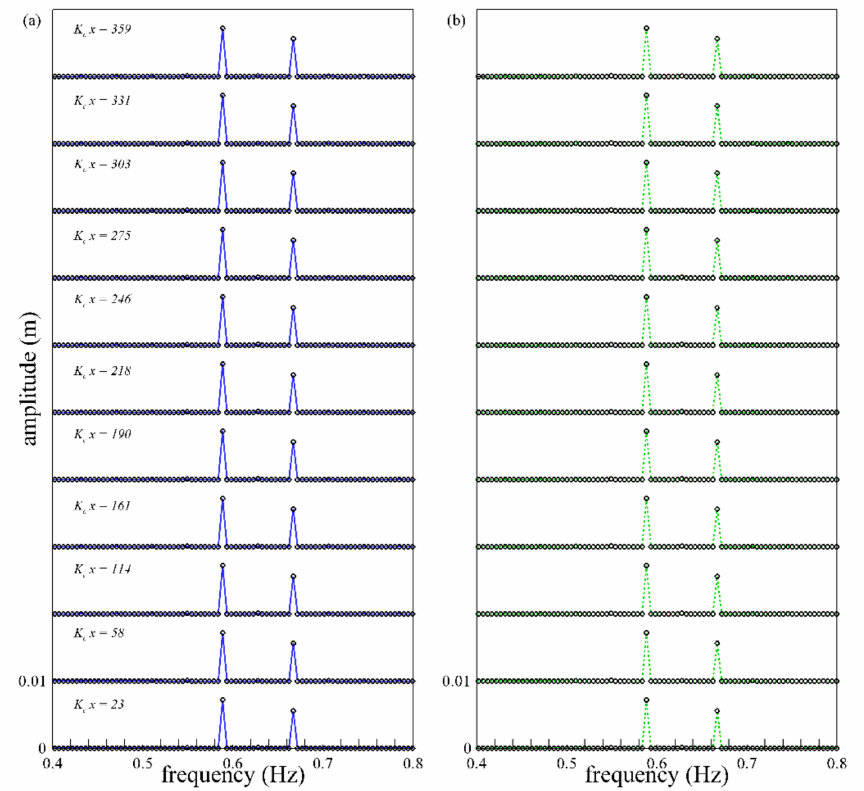
Figure 10. The predicted amplitude spectra from the ( a ) FNHS results and ( b ) QNHS results for linear bi-chromatic waves: analytical solutions (circles), FNHS mode (solid lines), and QNHS mode (dashed